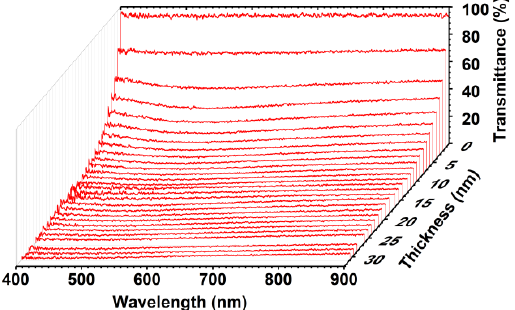
Figure 4. In situ transmittance evolution during Cr film growth.